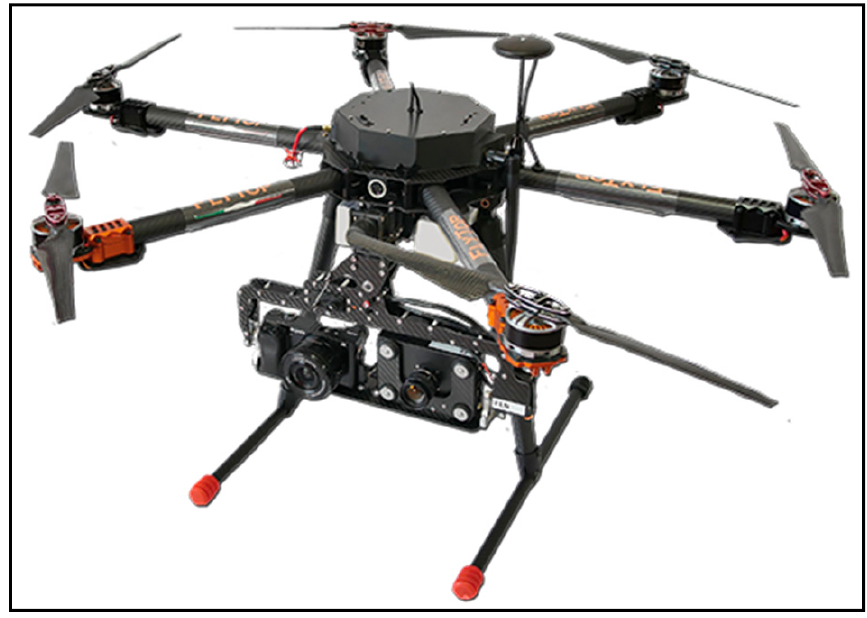
Figure 1. FlyNovex UAV (unmanned aerial vehicle) system. Table 1. Calibration parameters of the camera.